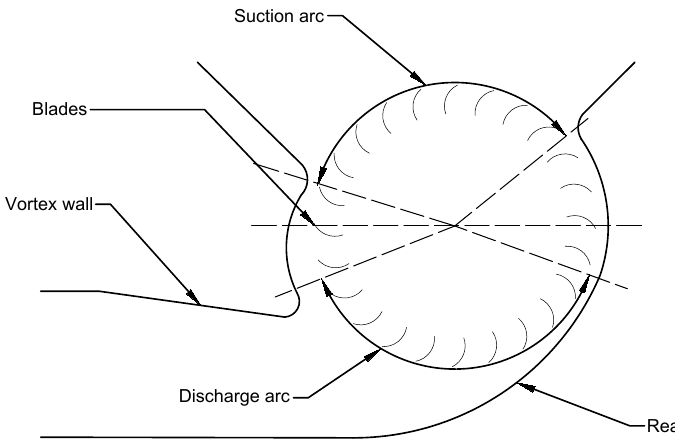
Figure 1. The Eck/Laing CFF design.